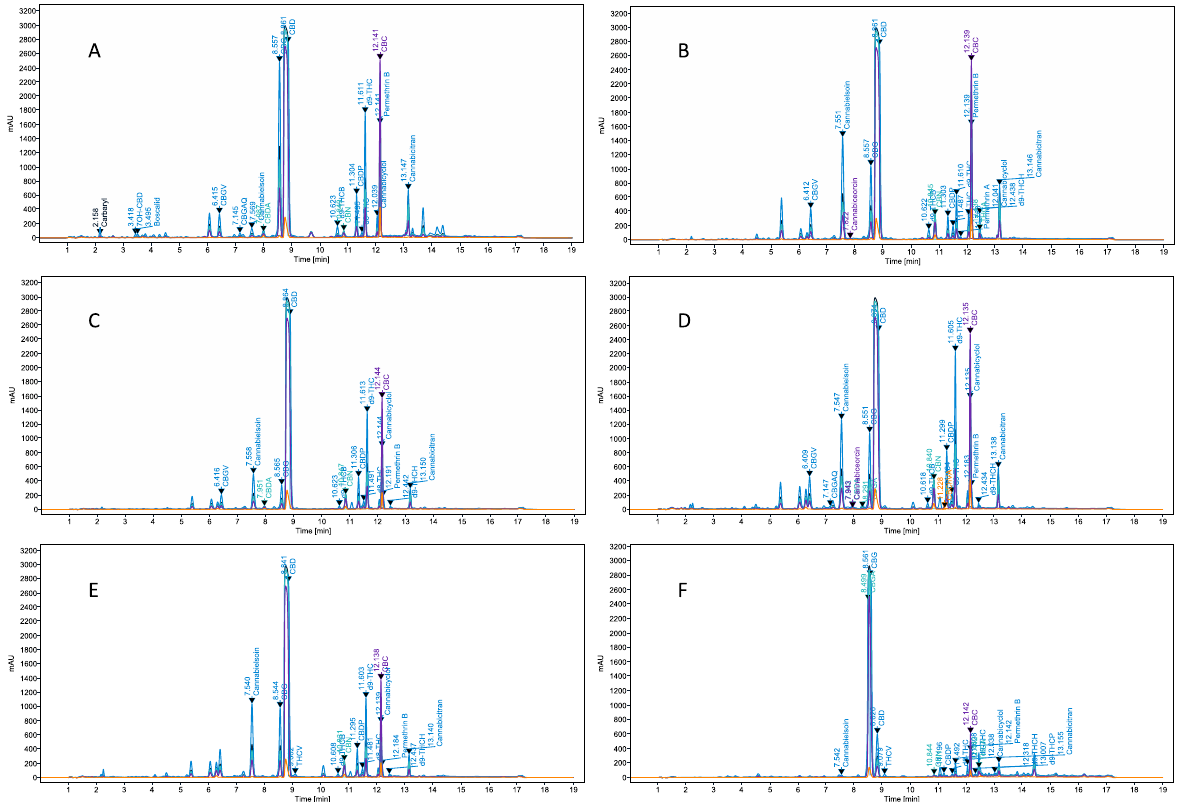
Fig. 4 Representative chromatograms of A raw flower, B crude CO 2 extract, C crude ethanol extract, D CBD distillate, E mother liquor, and F distillation bottoms. Each matrix sample was spiked with carbaryl, boscalid, and spinosyn A for reference. The ratio of CBDA to CBD occurs in greatest proportion in the raw flower sample, because the biomass is decarboxylated with heat prior to crude extraction. CBD/CBDA was observed in greatest relative abundance for each of the matrices except the distillation bottoms, where CBG occurs in greatest